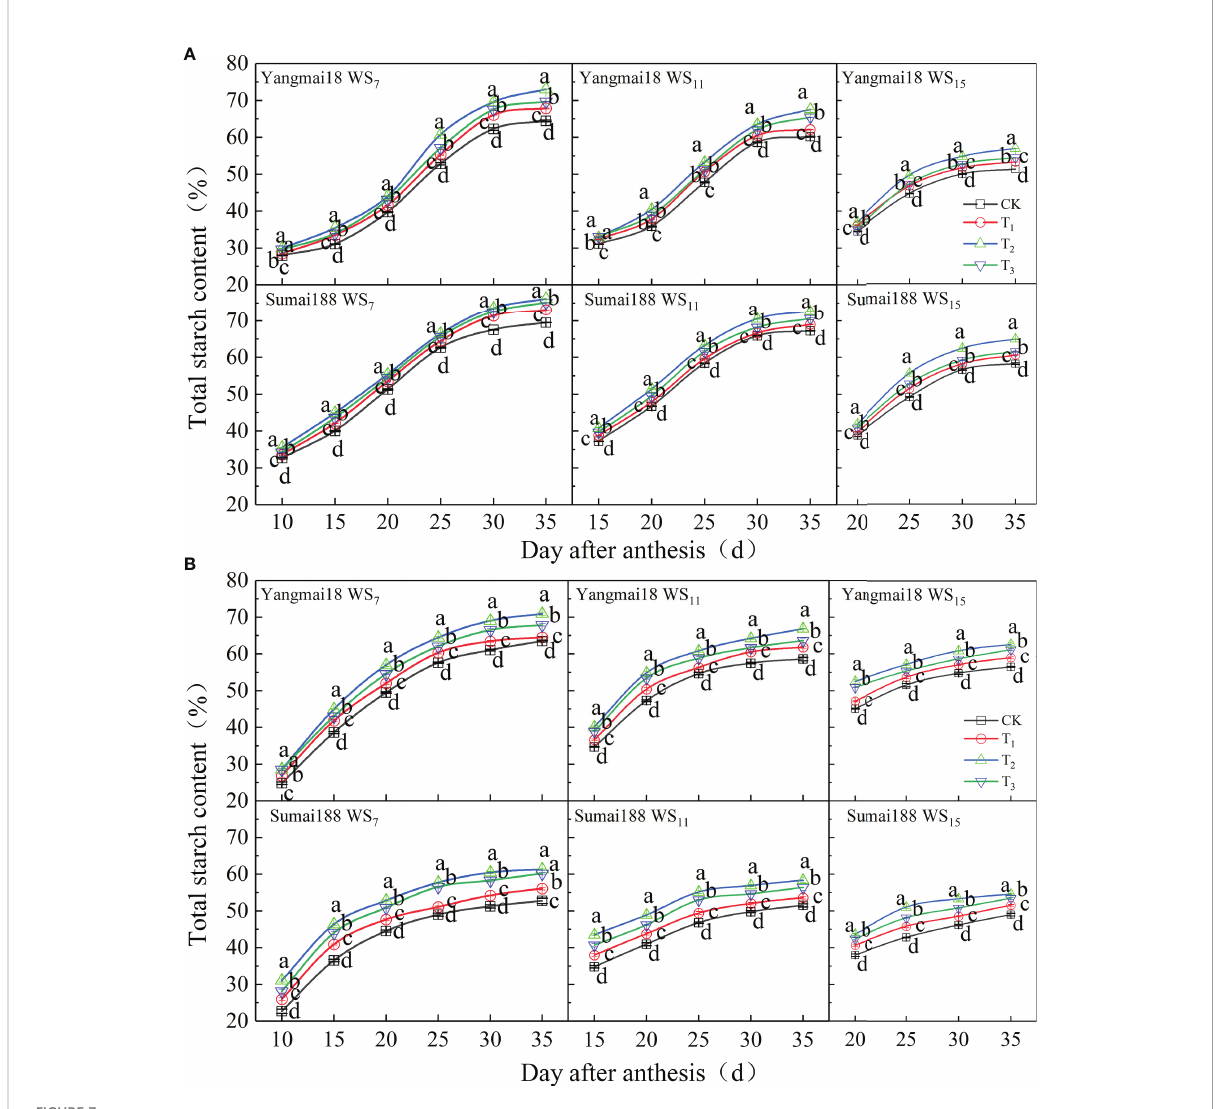
FIGURE 7 The effect of exogenous 6-BA on total starch accumulation of wheat under waterlogging and shading in 2021 (A) and 2022 (B) . WS 7 , WS 11 , and WS 15 respectively represent treatments under waterlogging and shading for 7, 11, and 15 days after anthesis. Shade nets with a shading rate of about 45% were used for shading, and waterlogging preserves about 2 cm of moisture on the surface of the soil. CK refers to the control sprayed with distilled water. T 1 , T 2 , and T 3 refer to the concentration of 6-BA sprayed (15, 25, and 35 mg·L − 1 ). Each value is expressed as mean ± SE ( n = 3). Different lowercase letters embedded in the linear graph express signi fi cant differences among treatments ( p<